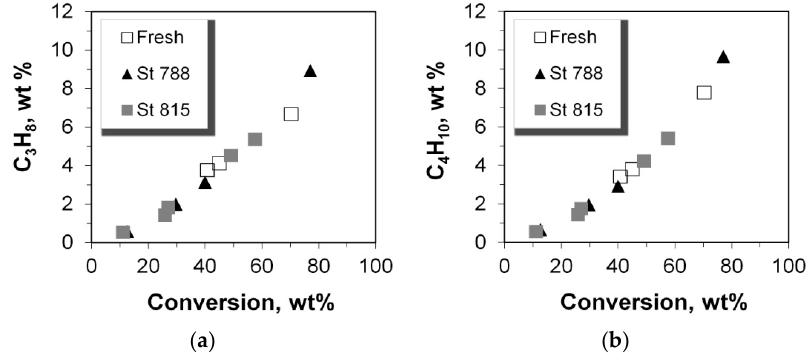
Figure 10. Mass ratio of propylene over butylenes versus the conversion of n-C 12 . Molecules 2017 , 22 , x FOR PEER REVIEW